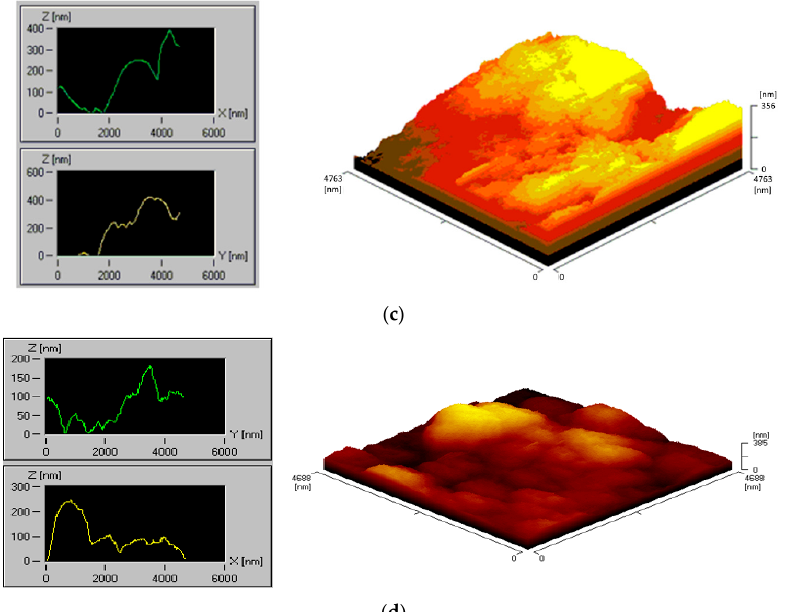
Figure 15. Ra profile on the spherical surfaces of ball joints for Peugeot 206: ( a ) Manufacturer ball joint, mileage: below 30,000 km, vehicle age: 1 year; ( b ) Replacement part ball joint, mileage: 40,000 km, vehicle age: 3.5 years; ( c ) Manufacturer ball joint, mileage: 115,000 km, vehicle age: 8 years; ( d ) Manufacturer ball joint, mileage: 90,000 km, vehicle age: 7 years.